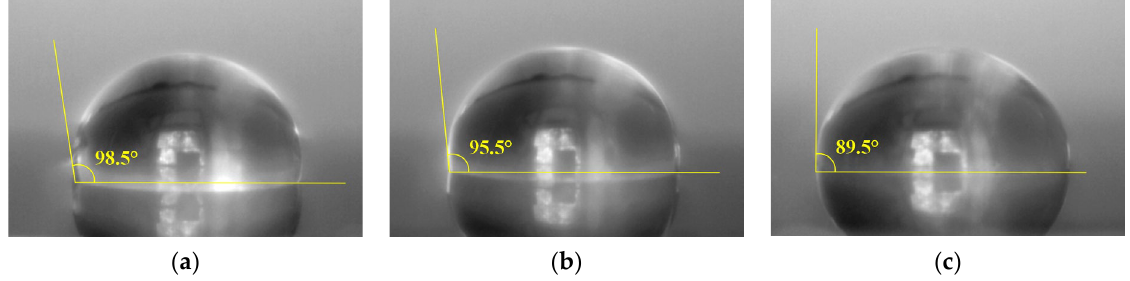
Figure 15. Water contact angle test for the deposited layer when using HiPIMS power supply for the deposition times of ( a ) 5 min, ( b ) 10 min and ( c ) 15 min.